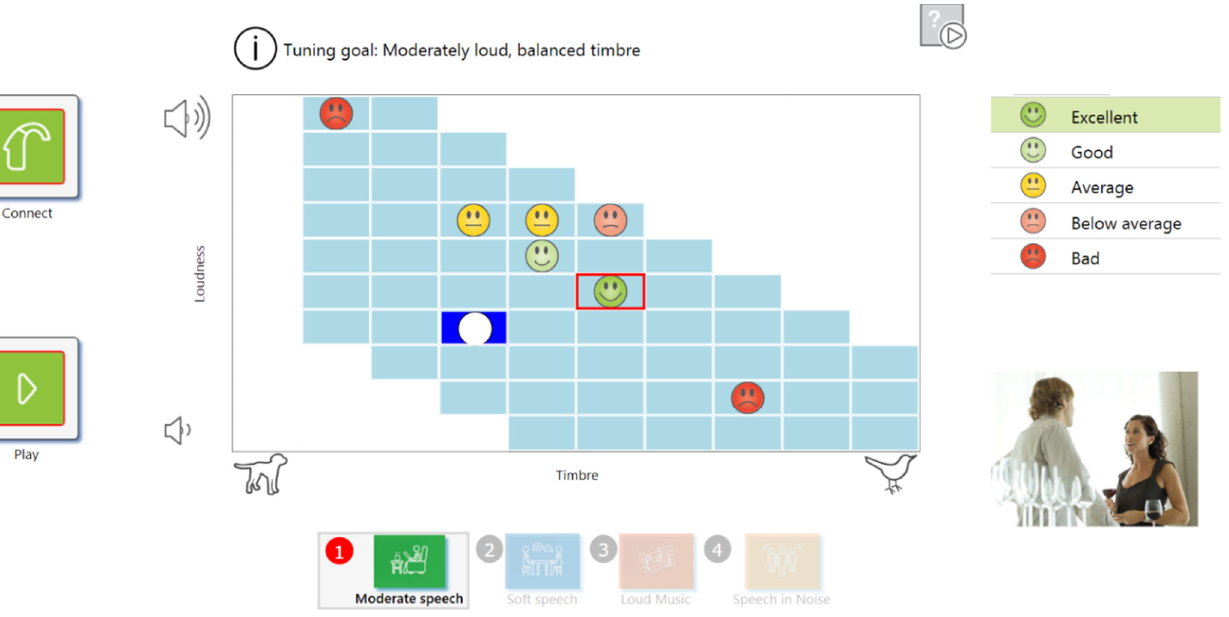
Figure 1. User interface of self-fitting system implemented in the fitting software .